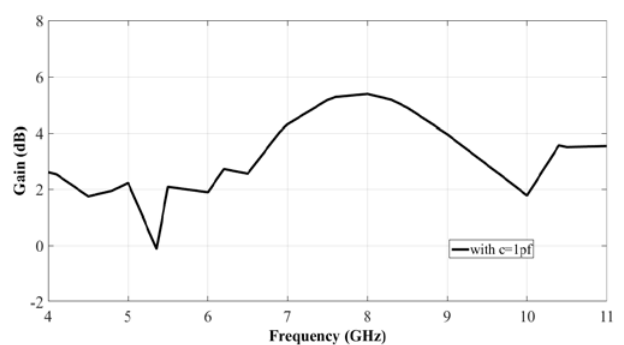
Figure 11: The group delay